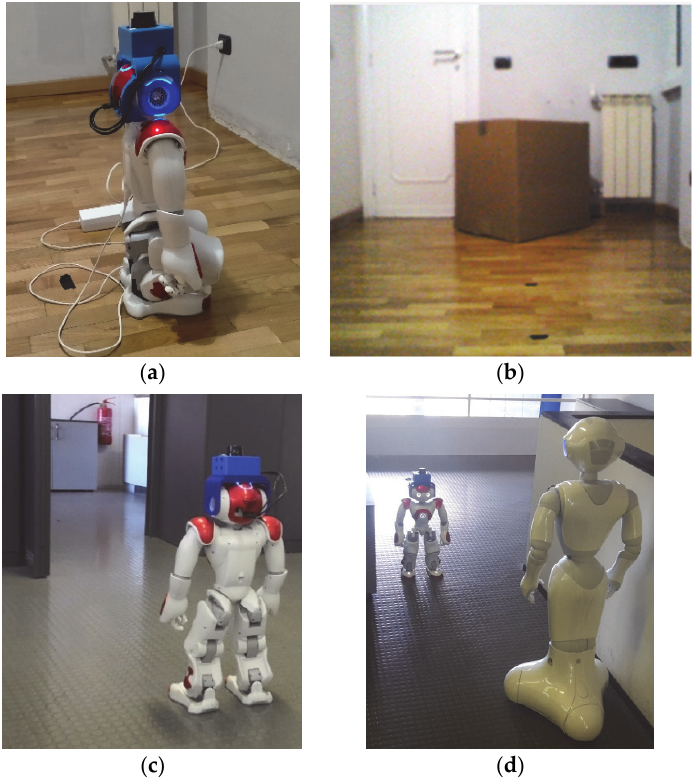
Figure 8. Measurement setups for test #1 ( a ) and test #2 scenario #1 ( b ), #2 ( c ) and #3 ( d ).